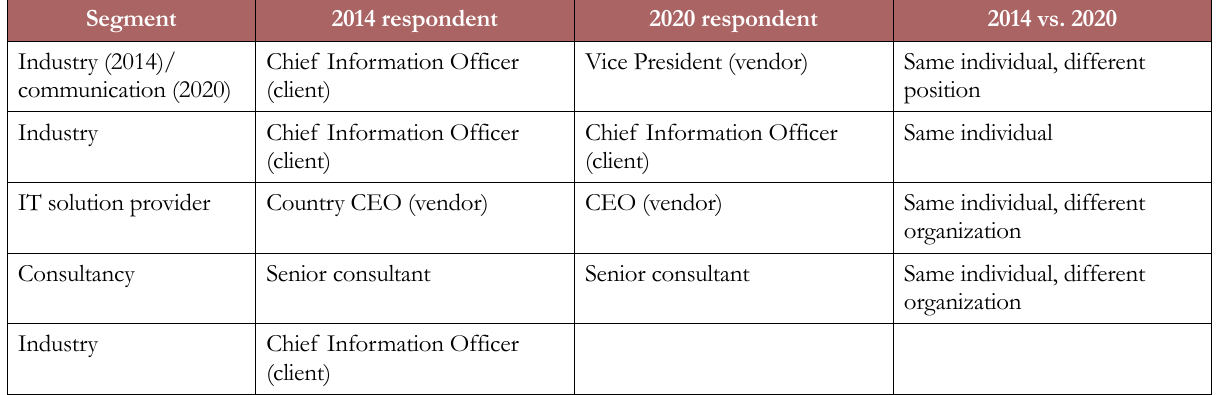
Table 2. Respondents for the ITO